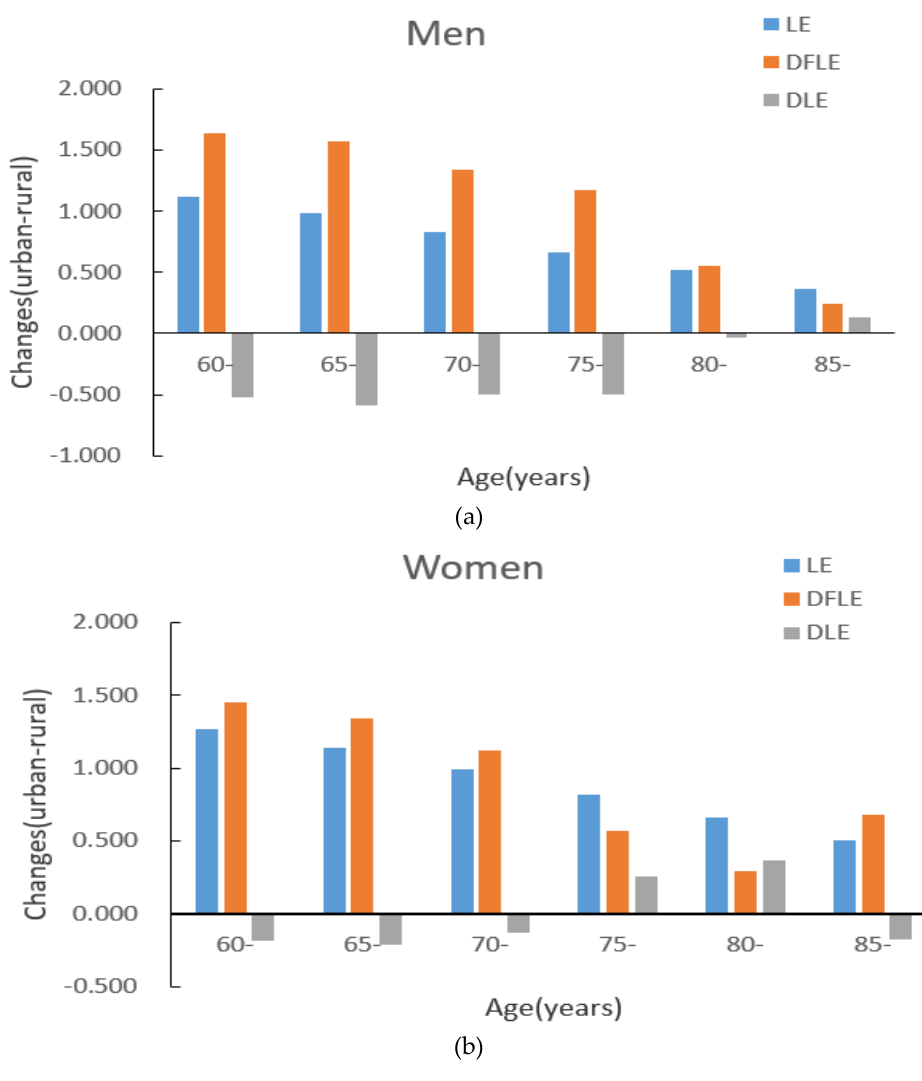
Figure 3. Absolute changes in life expectancy (LE) and disability-free life expectancy (DFLE) between urban and rural areas for men and women. ( a ) men ( b ) women.